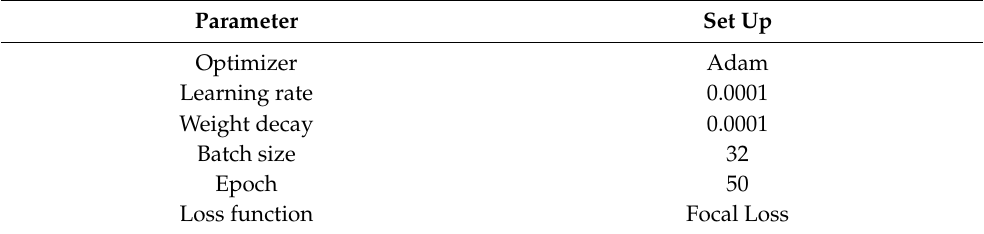
Table 3. Model parameter settings.